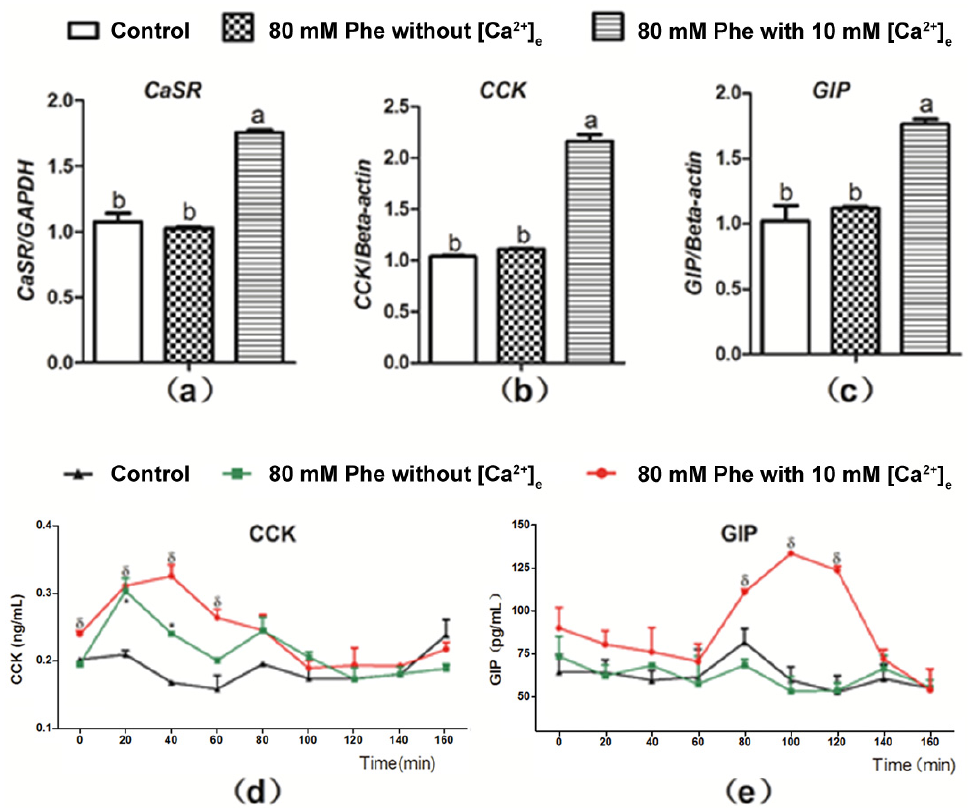
Figure 4. E ff ect of [Ca 2 + ] e on expression level of mRNA of CaSR, CCK, and GIP, as well as secretion of CCK and GIP induced by Phe in pig duodenum. Perfusion of duodenal tissues was performed with KHB without Phe and [Ca 2 + ] e (the control group), and 80 mM Phe with or without 10 mM [Ca 2 + ] e . After 160 min of perfusion, the tissues were collected for qPCR analysis for expression of ( a ) CaSR, ( b ) CCK, and ( c ) GIP; GAPDH and β -actin were used as internal controls. The perfusate solutions were obtained at a 20 min interval to determine the concentrations of ( d ) CCK and ( e ) GIP using corresponding ELISA kits. Values are presented as mean and SEM ( n = 5). For each gene ( a – c ), means with dissimilar letters di ff er significantly at p < 0.05. For the same time-points ( d , e ), significant di ff erences at p < 0.05 are indicated using * and δ for treatment with 80 mM Phe in the absence of Ca 2 + and in combination with 80 mM Phe and 10 mM Ca 2 + , respectively, compared with the control group.